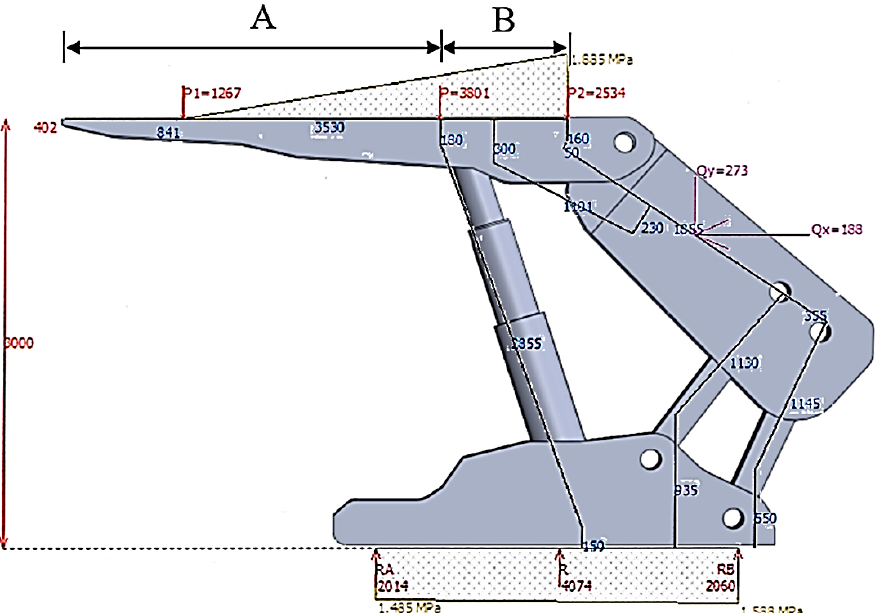
Figure 9. Distribution of forces and pressures along the canopy and the base of powered roof supports due to interaction with the rock mass, where: A—distance from the beginning of the canopy to the hydraulic leg socket, B—distance from the end of the canopy to the hydraulic leg socket. The pressure distribution along the canopy of the 2-leg shield shows a trapezoidal distributed loading characteristic with a maximum value of approx. 1.90 Mpa. The pressure distribution along the base shows a rectangular distributed loading characteristic with minimum and maximum values of approx. 1.50 Mpa and 1.60 Mpa, respectively.